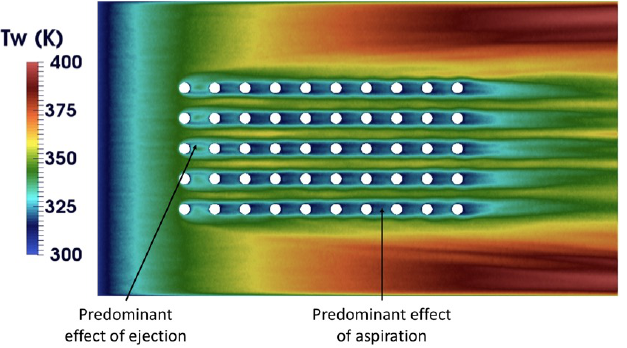
Figure 9. Plate temperature field averaged over five periods obtained with Φ = 1500 W.m − 2 .